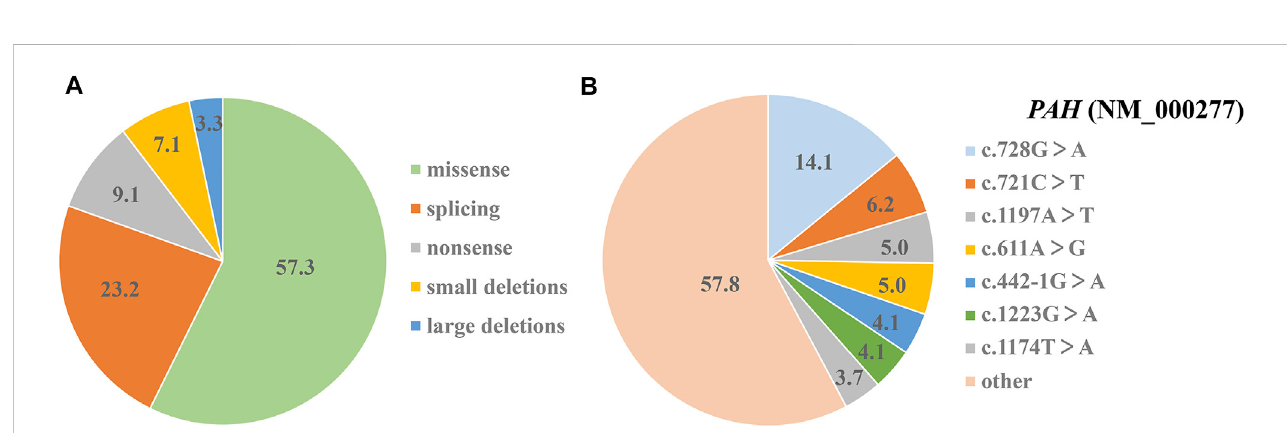
FIGURE 4 Shares of mutational analysis of 123 PAHD patients. (A) The proportion of fi ve different kinds of positive variant fi ndings (%). (B) The relative frequency of various detected variants (%).